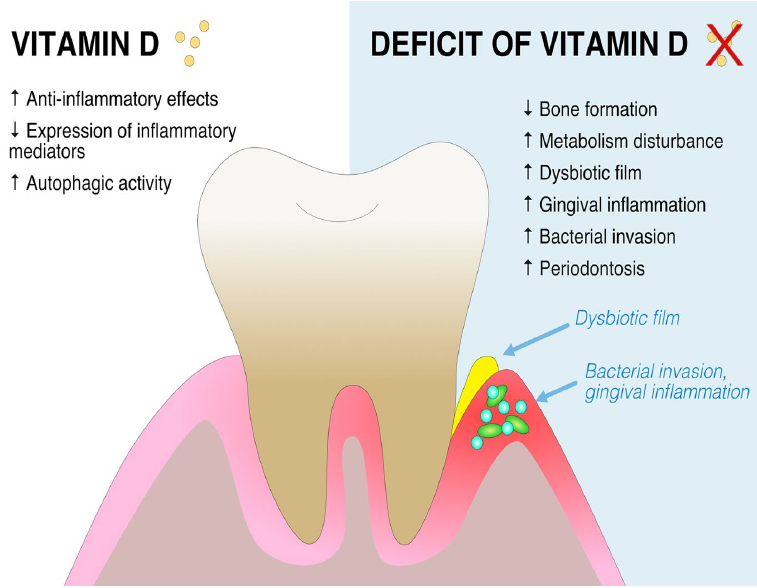
Figure 2. The role of vitamin D and possible effects of its deficiency on the periodontal tissue. Table 2. A summary of the most important studies on the effects of VitD on periodontal health.